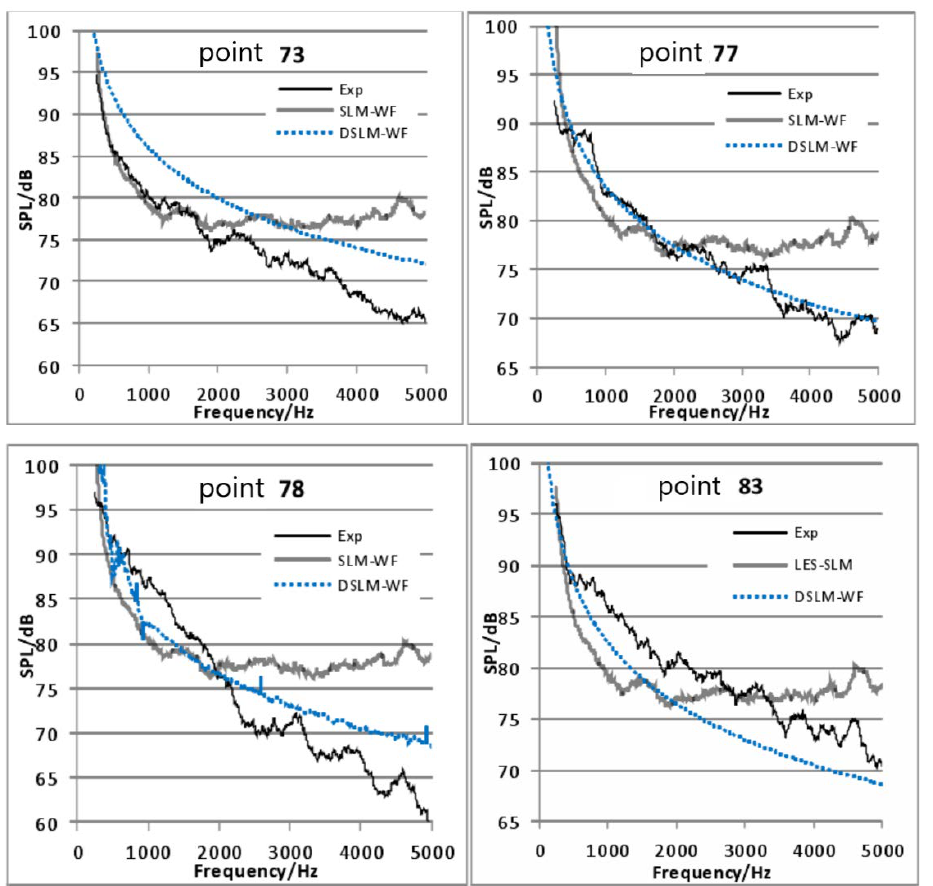
Figure 17. Sound pressure levels on the front side window obtained in the simulation and test.